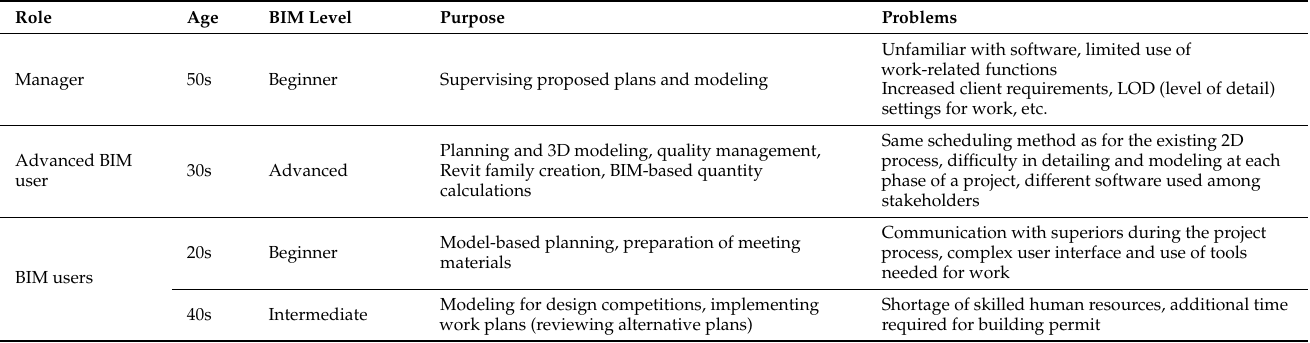
Table 3. Representative personas for BIM software users in design